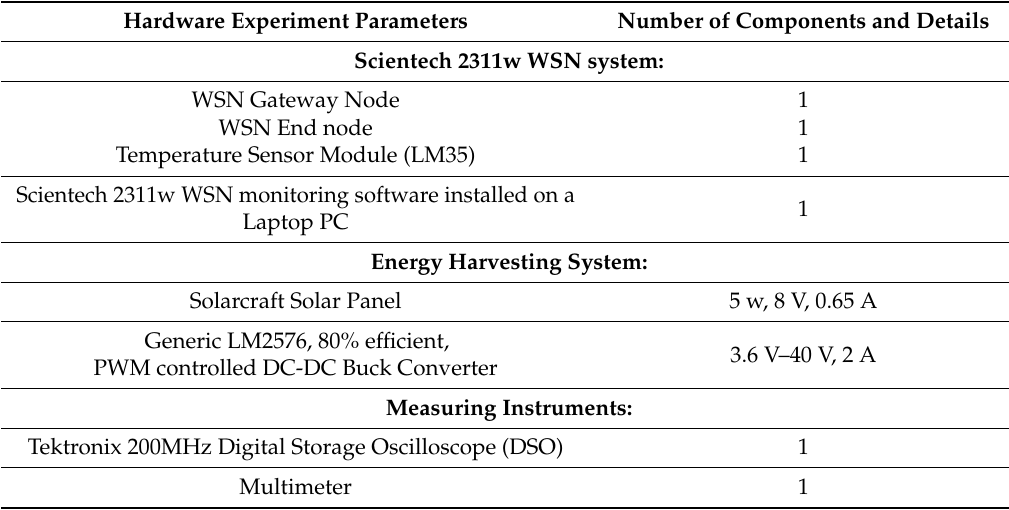
Table 3. Hardware Experiment